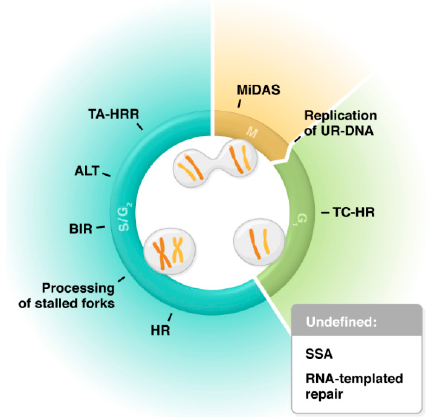
Figure 1. Involvement of RAD52 in various pathways of genome maintenance: TC-HR (transcription-coupled homologous recombination), HR (homologous recombination), Processing of stalled forks (MUS81-dependent fork cleavage and protection against excessive fork reversal), BIR (break-induced replication), ALT (alternative lengthening of telomeres), TA-HRR (transcription-associated homologous recombination repair), MiDAS (mitotic DNA synthesis), Replication of UR-DNA (replication of under-replicated DNA in 53BP1 nuclear bodies), SSA (single-strand annealing), and RNA-templated repair. Pathways are categorized by the cell cycle phase in which they are predominately active [24 – 30].